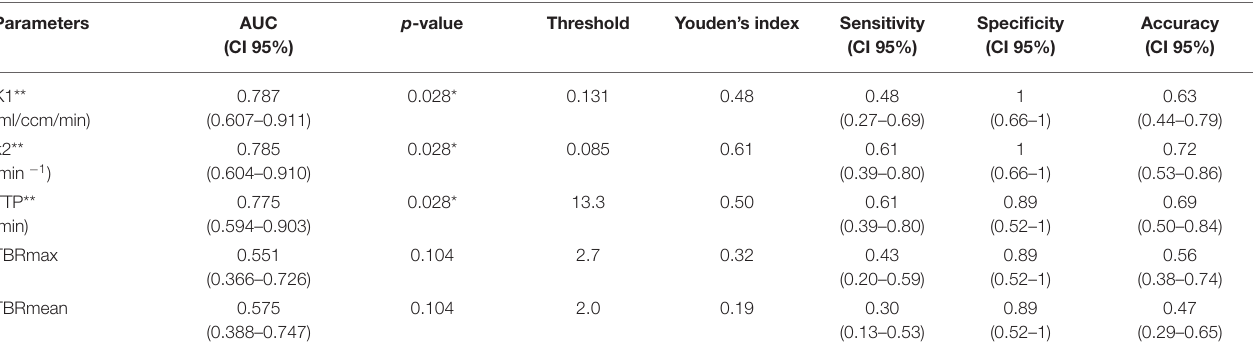
TABLE 3 | Diagnostic performances of FDOPA parameters for discrimination of LGG and HGG.